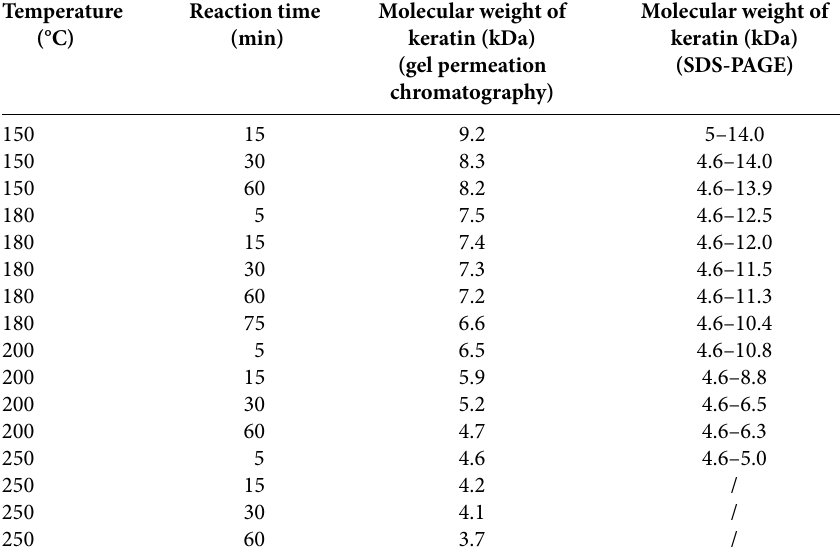
Table 4. Molecular weight of keratin.